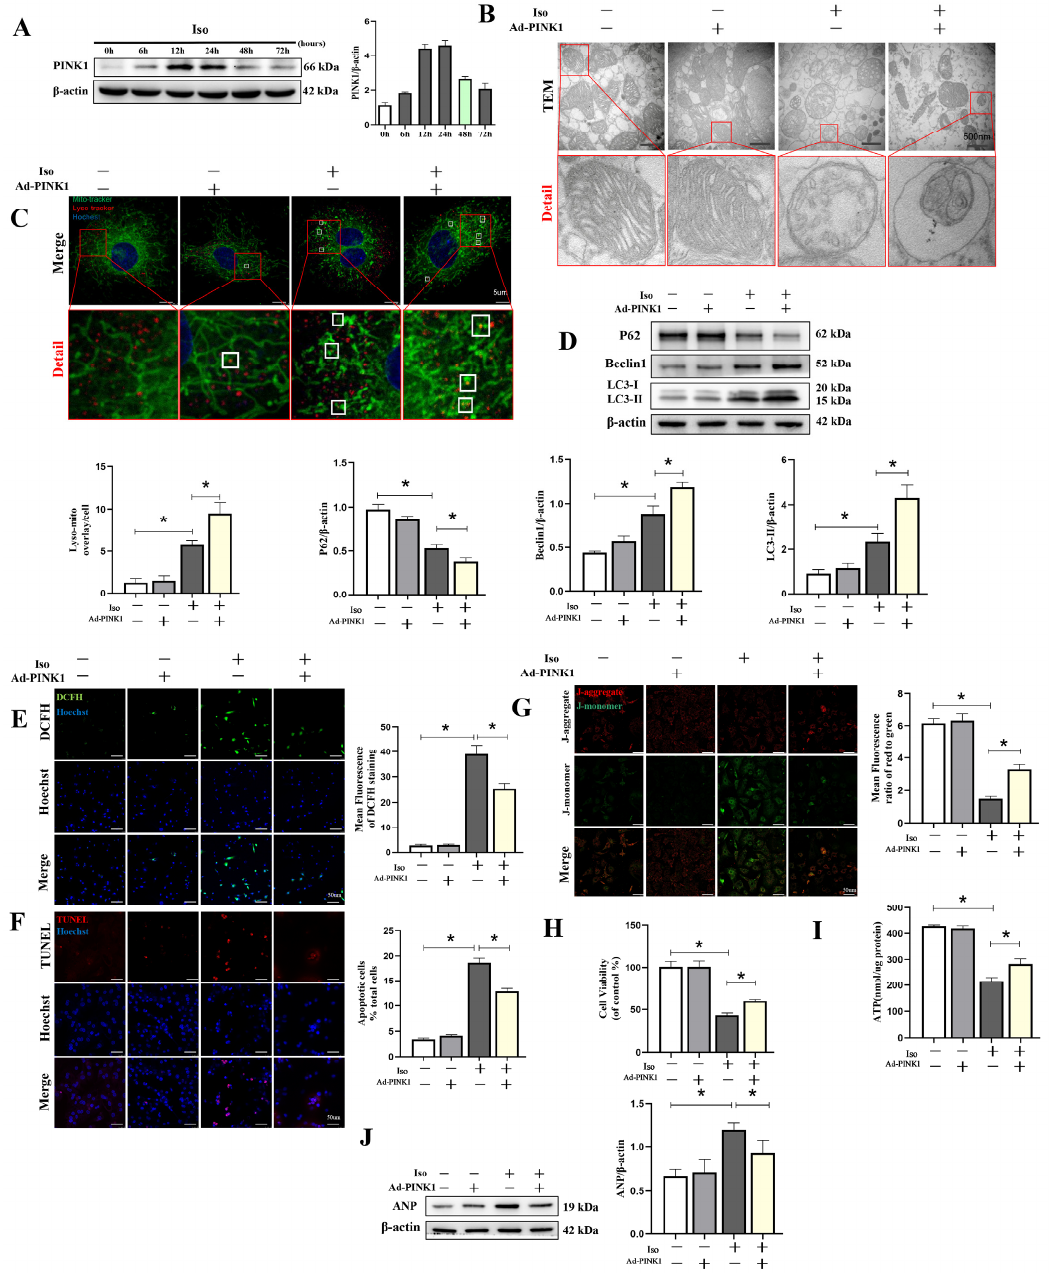
Figure 1. Overexpression of PINK1 attenuated isoprenaline-induced cardiomyocyte injury by mi- tophagy. Adenoviruses Ad-PINK1 and Ad-control were used to transfect cardiomyocytes and then stimulated with Iso (10 uM) for 48 h. ( A ) Western blot showing the expression of PINK1 over time. ( B ) Mitochondrial morphology was shown by TEM in cardiomyocytes. Details of mito- chondrial structures are shown in the red frame. ( C ) Representative immunofluorescence images of lysosomal–mitochondrial interactions (yellow). Lysosomes are shown in red, mitochondria are shown in green, and nuclei are shown in blue. ( D ) Western blot showing the expression levels of P62, Beclin1 and LC3 II in each group. Quantification relative to β -actin levels. ( E ) DCFH staining was used to show ROS production (green) in cardiomyocytes. ( F ) Apoptotic cardiomyocytes (red) were examined by TUNEL staining. ( G ) Fluorescence images of MMP detected by JC-1 tracker. J-aggregate staining is shown in red and J-monomer staining is shown in green. ( H ) Cell viability was